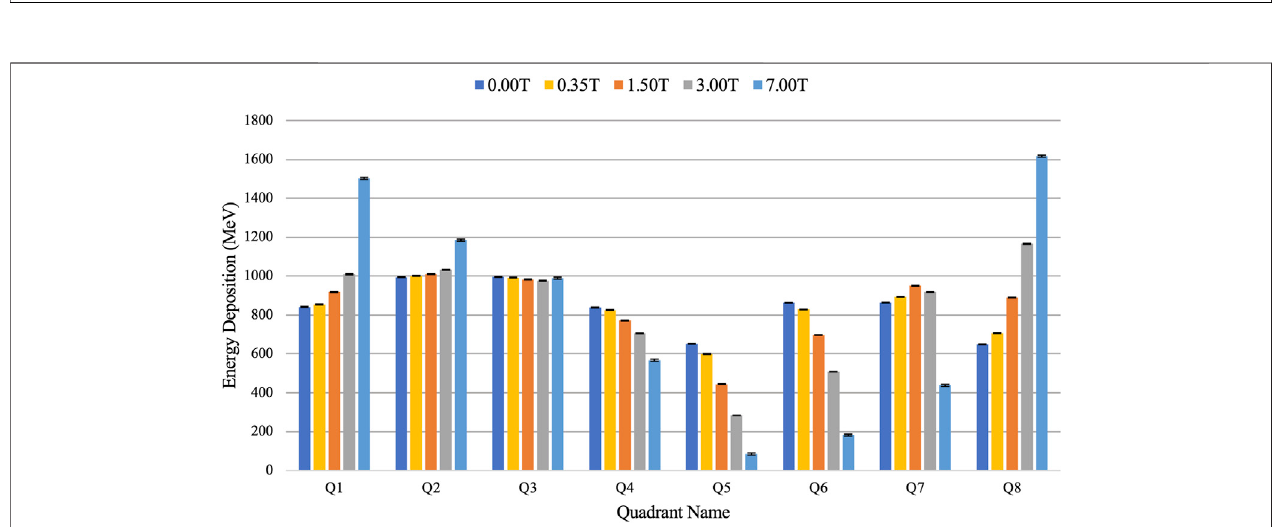
FIGURE 4 | Comparison of energy deposition in each quadrant of the water shell of the alveolus model with varying magnetic fi eld strength.